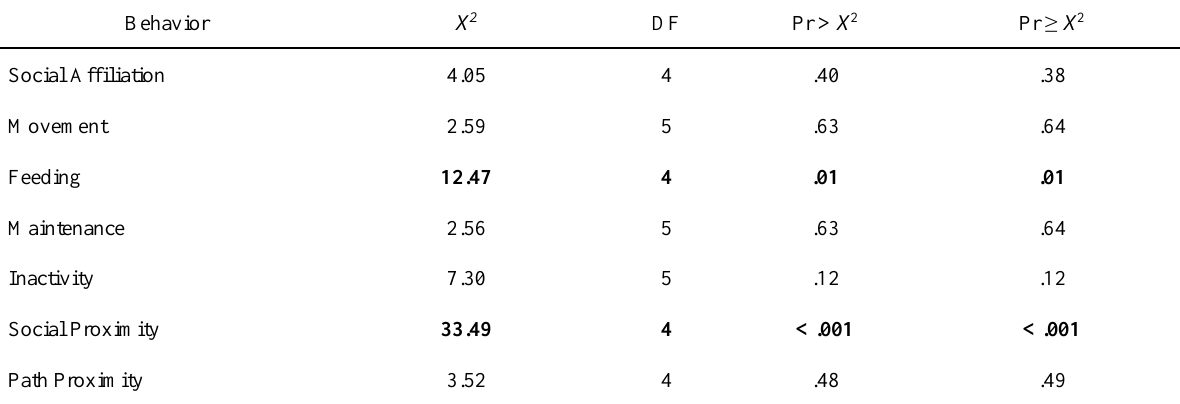
Kruskal-Wallis Tests with Monte Carlo Correction Results for Behavioral Variation Between Crowd Size Conditions Behavior